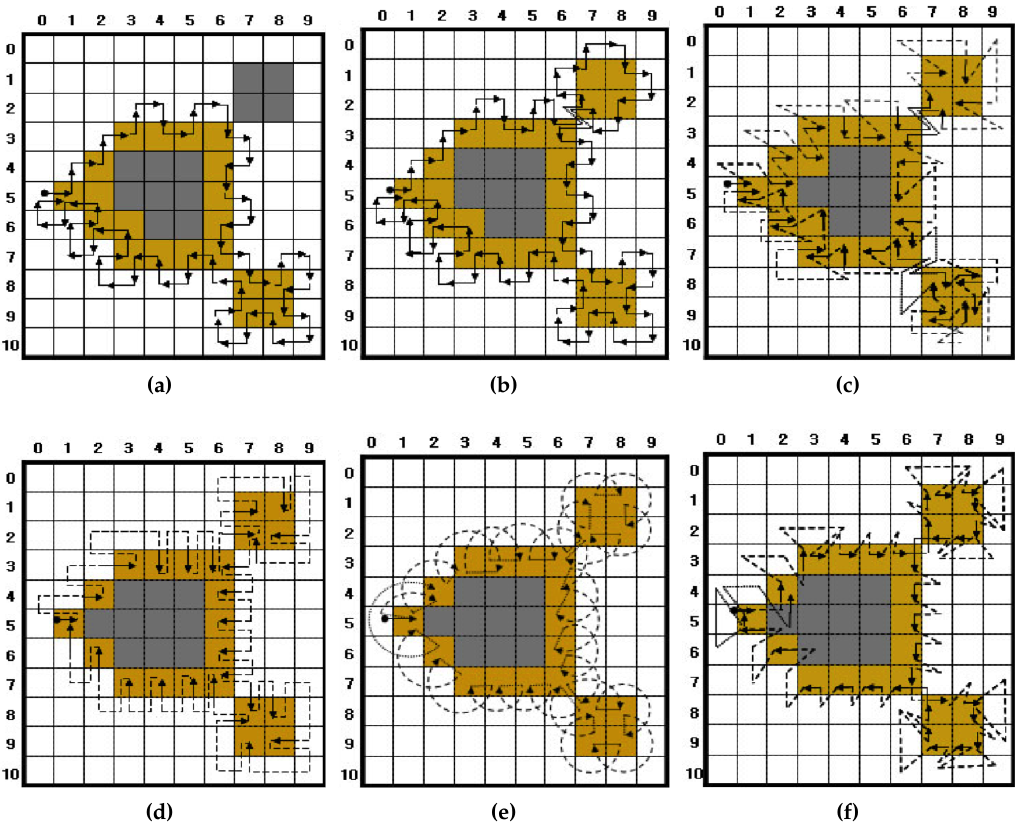
Figure 8. Comparison of conventional contour pixel-following algorithms: ( a ) SBF; ( b ) MSBF; ( c ) ISBF; ( d ) MNT; ( e ) RSA; ( f )